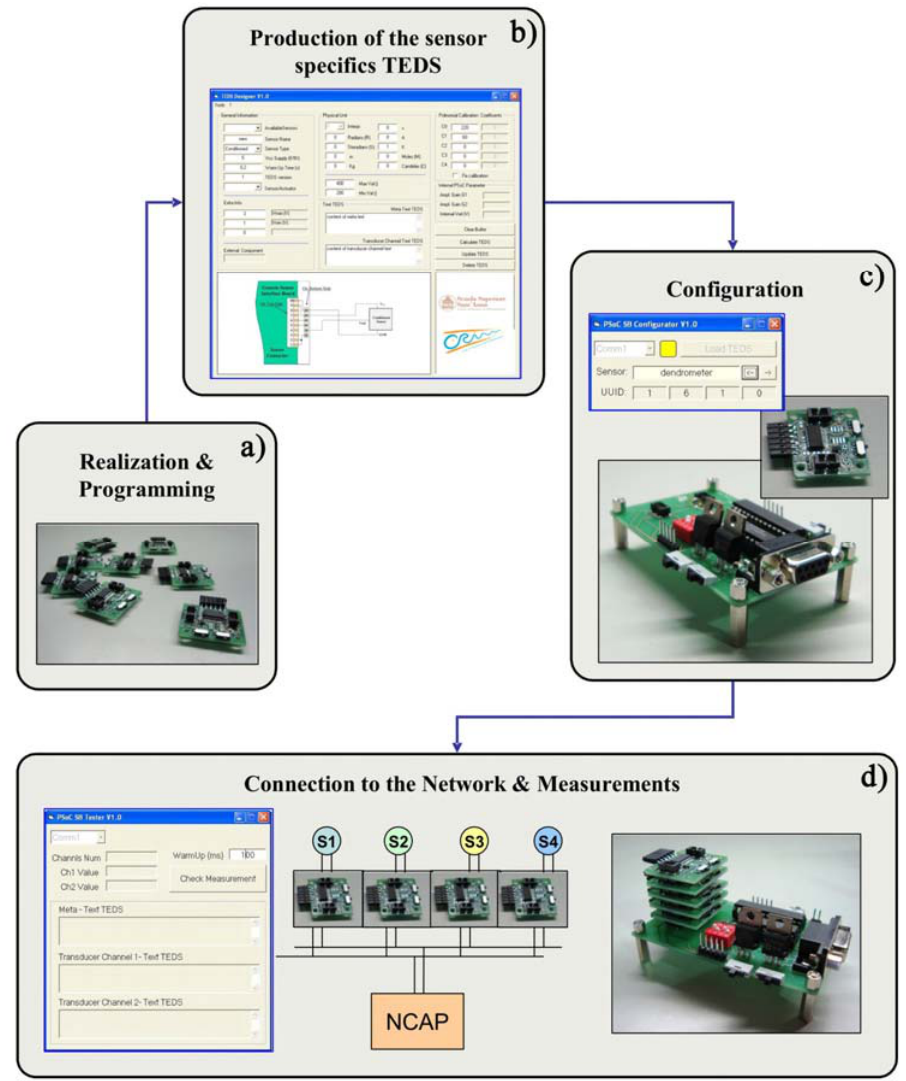
Figure 3. UISI programming cycle: (a) programming of all the UISIs with a common firmware that contains all the required functionalities; (b) TEDS is generated on the base of the specific sensor to be integrated; (c) TEDS parameters are loaded on the board by configuration tools; (d) UISI is connected to the sensor and to the NCAP and is ready for